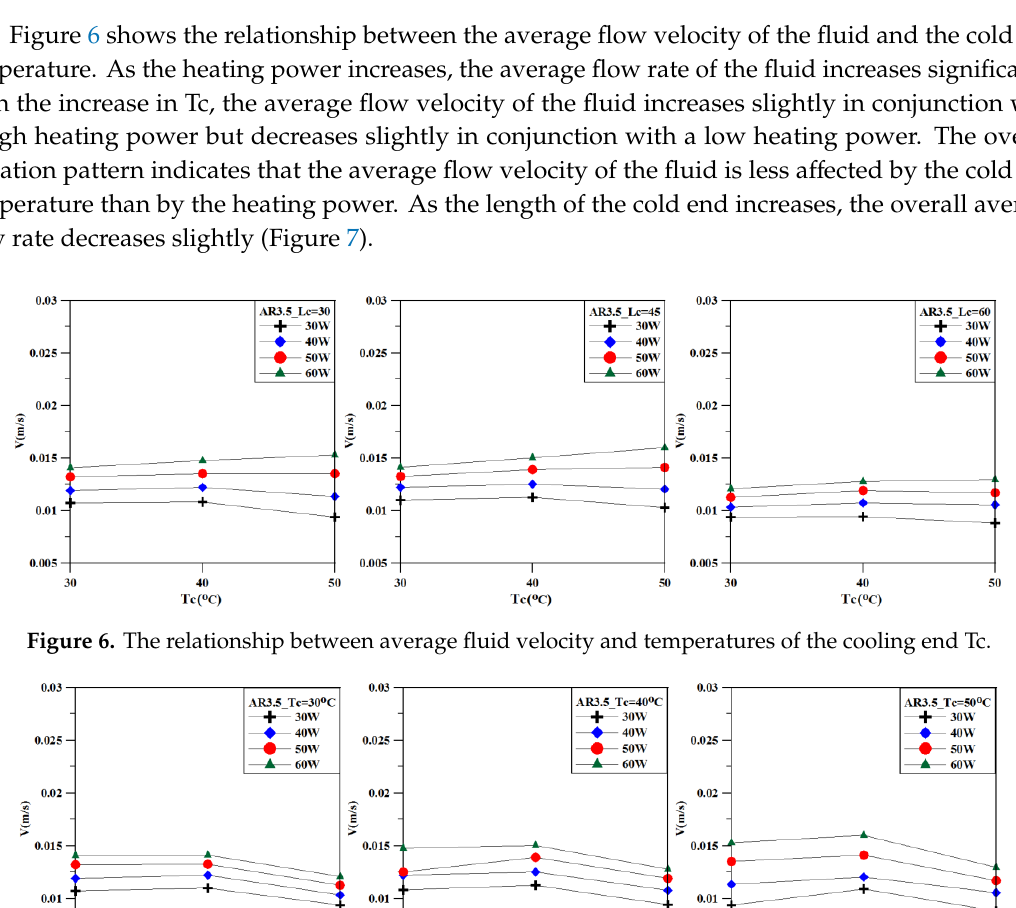
Figure 5. The relationship between the Nusselt number of loop flow and the modified Rayleigh number.